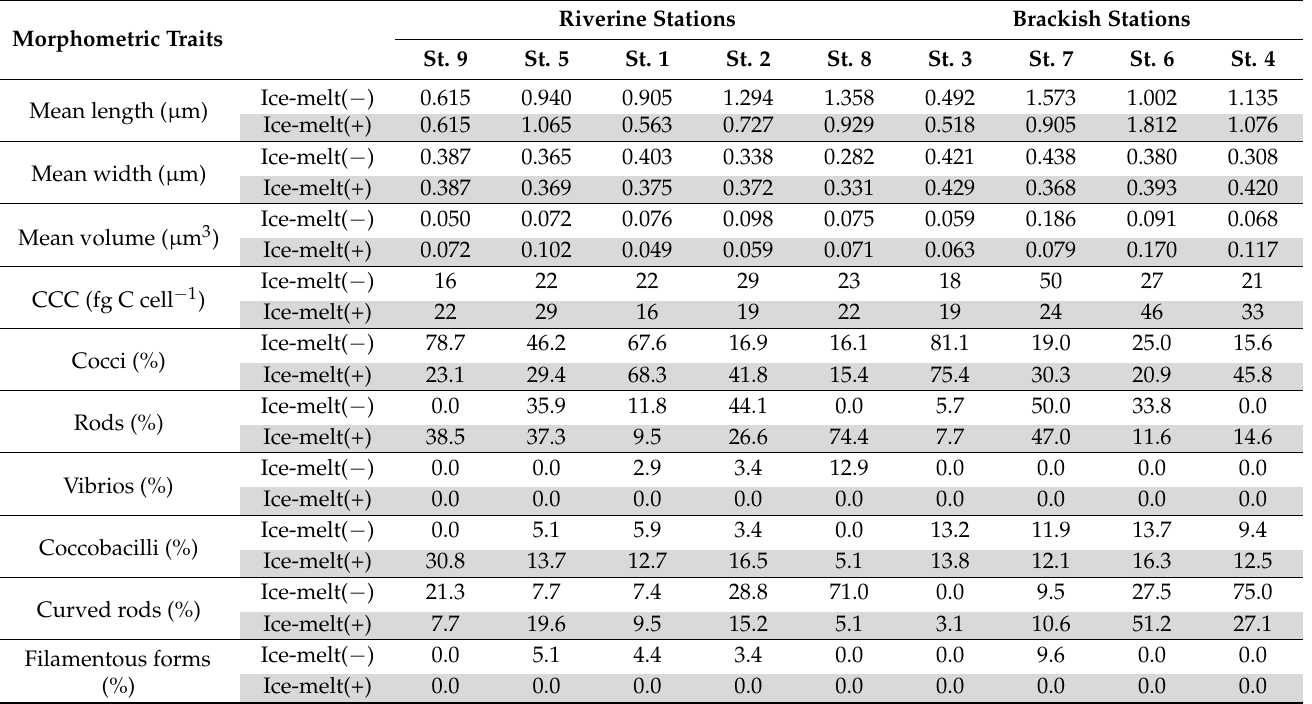
Table 3. Morphometric and morphological traits of prokaryotic cells in sediment samples collected in May (Ice-Melt( − )) and July (Ice-Melt(+)) 2014 along the Pasvik River. Morphometric